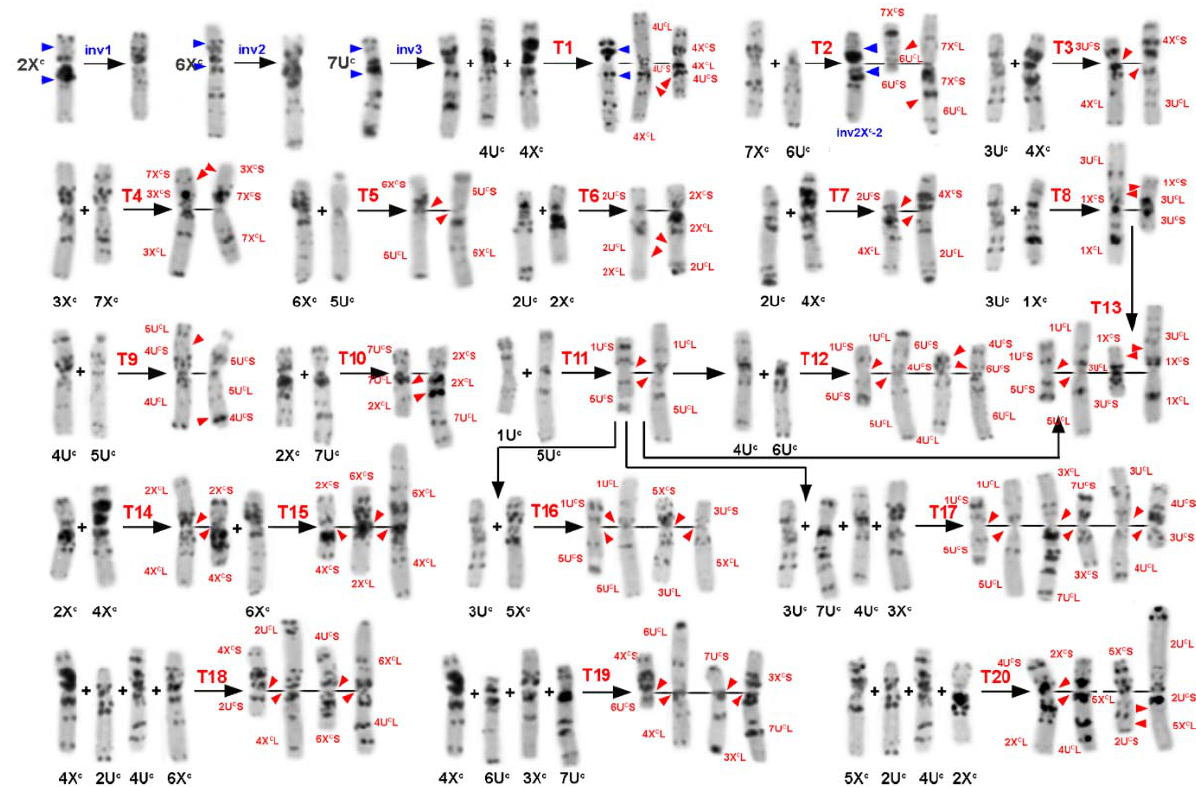
Figure 5. Translocation variants identified among 62 Ae. columnaris accessions belonging to group C-I. T1–T20—translocation variants; normal chromosomes are labeled with black letters and are shown below the respective chromosomes; arm combinations in translocated chromosomes are labeled with red letters. Inversions are identified—with blue. Red arrows point to possible translocation breakpoints, and blue arrows point to possible breakpoint positions in inverted chromosomes. Long black arrows define translocation lineages.